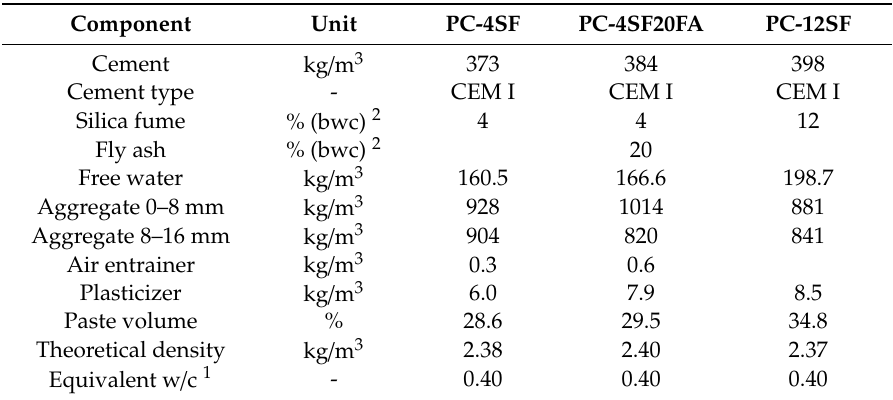
Figure 1. Picture of the concrete field station in Sandnessjøen. Table 1. Concrete compositions [27].